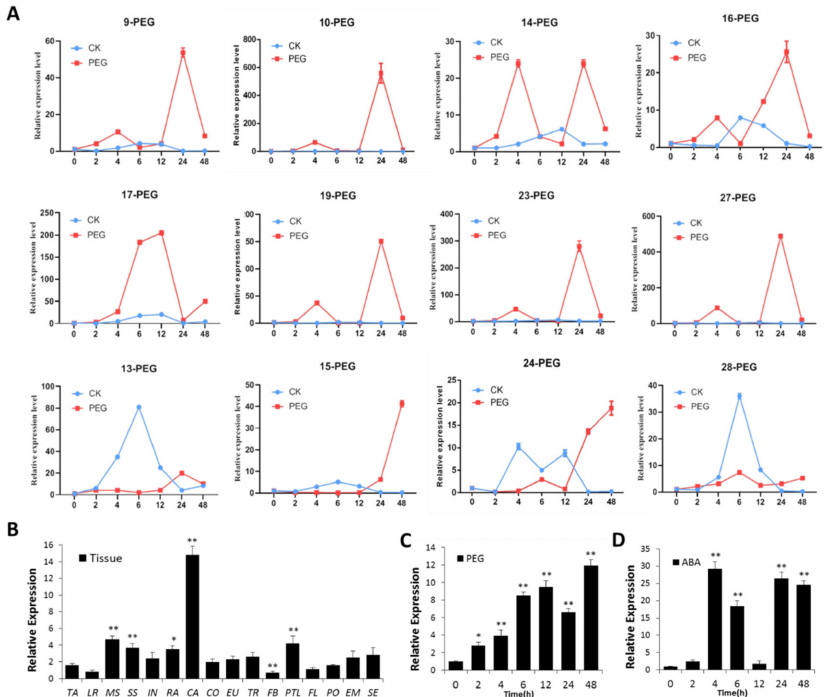
Figure 4. Expression patterns of GmNF-YB17 in soybean. *: p -value ≤ 0.05; **: p -value ≤ 0.01; ( A ) Twelve NFYB genes’ early response to drought stress, in which NFYB 13, 15, 24 and 28 are down-regulated; ( B ) Tissue-specific expression of GmNF-YB17 in soybean Maple Arrow. Tissues tested include taproot (TA), lateral root (LR), main stem (MS), side stem (SS), internode (IN),